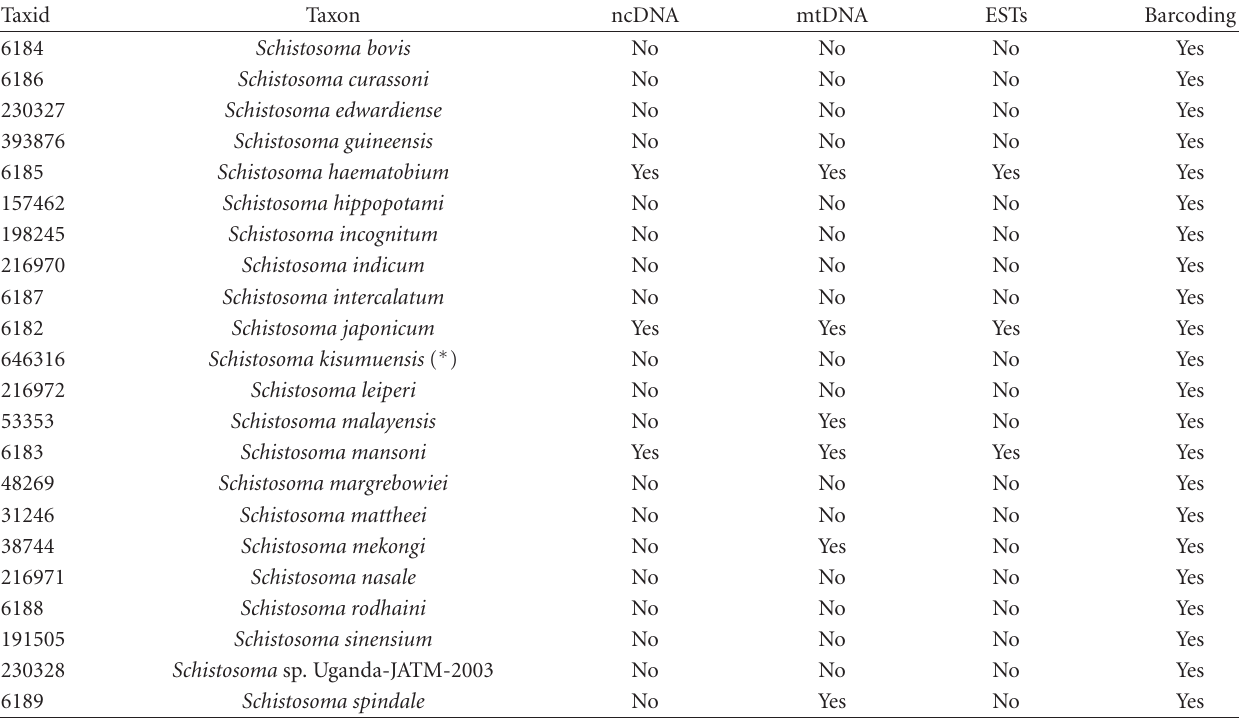
Table 1: Availability of genomic and transcriptomic data for Schistosoma